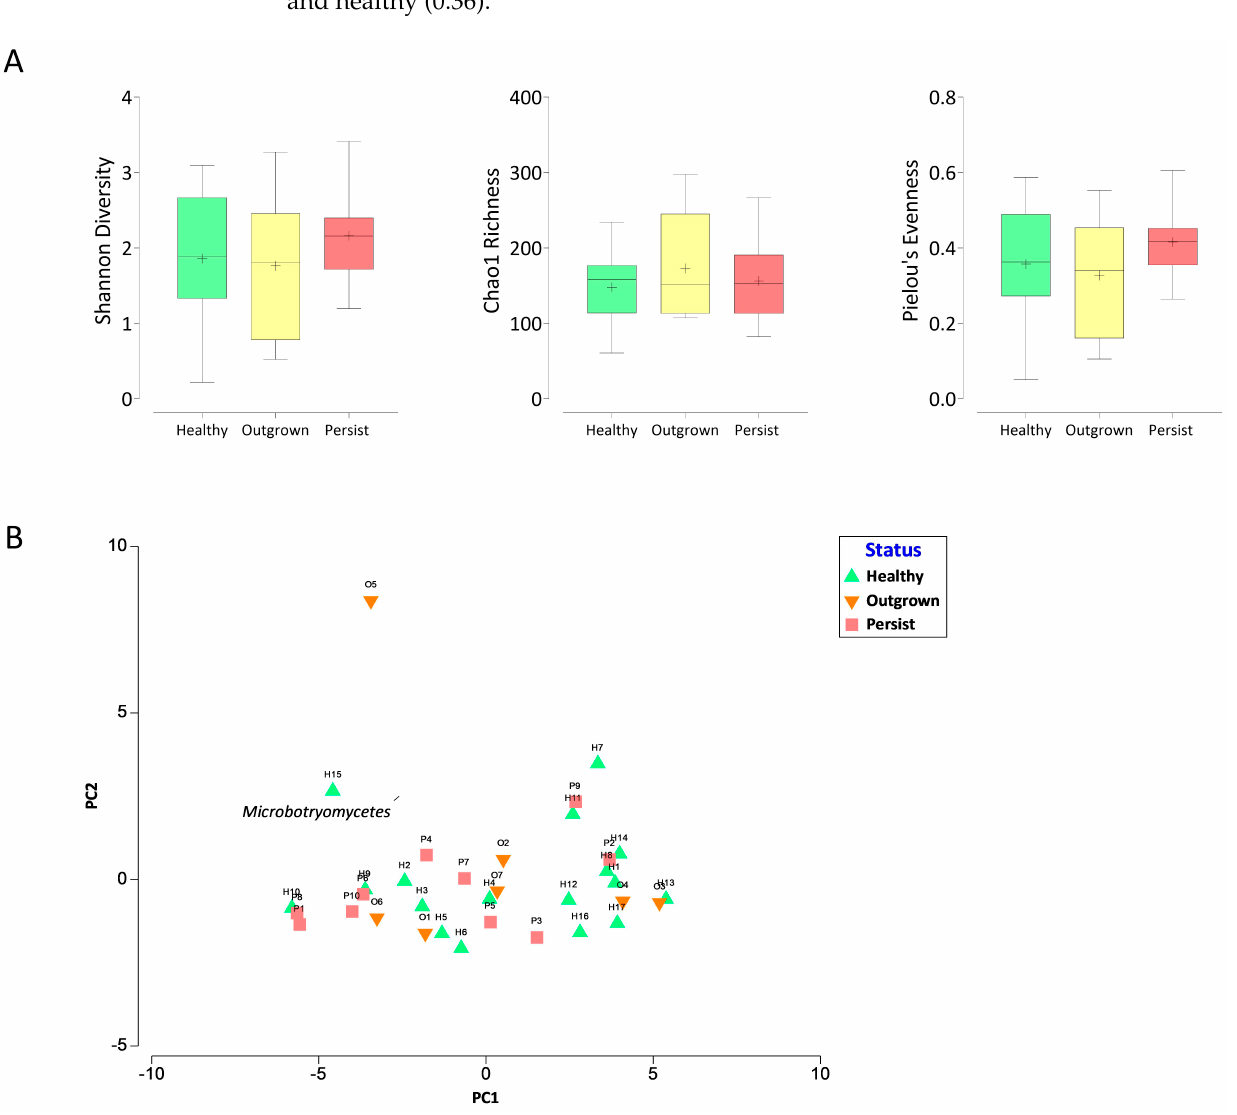
Figure 1. Gut mycobiome alpha diversity ( A ) and beta diversity ( B ) in healthy and atopic dermatitis infants. The alpha diversity is depicted as box and whisker plots; the horizontal line represents the median value, while the ‘+’ represents the mean value. Beta diversity is depicted by a Principal Component Analysis (PCA) plot generated based on the relative abundance percentage of fungi at the taxonomic class level. Bi-plot analysis was used to plot significantly different abundant taxa ( p -value 0.05). There was no statistically significant difference between the three groups ( p > 0.05).